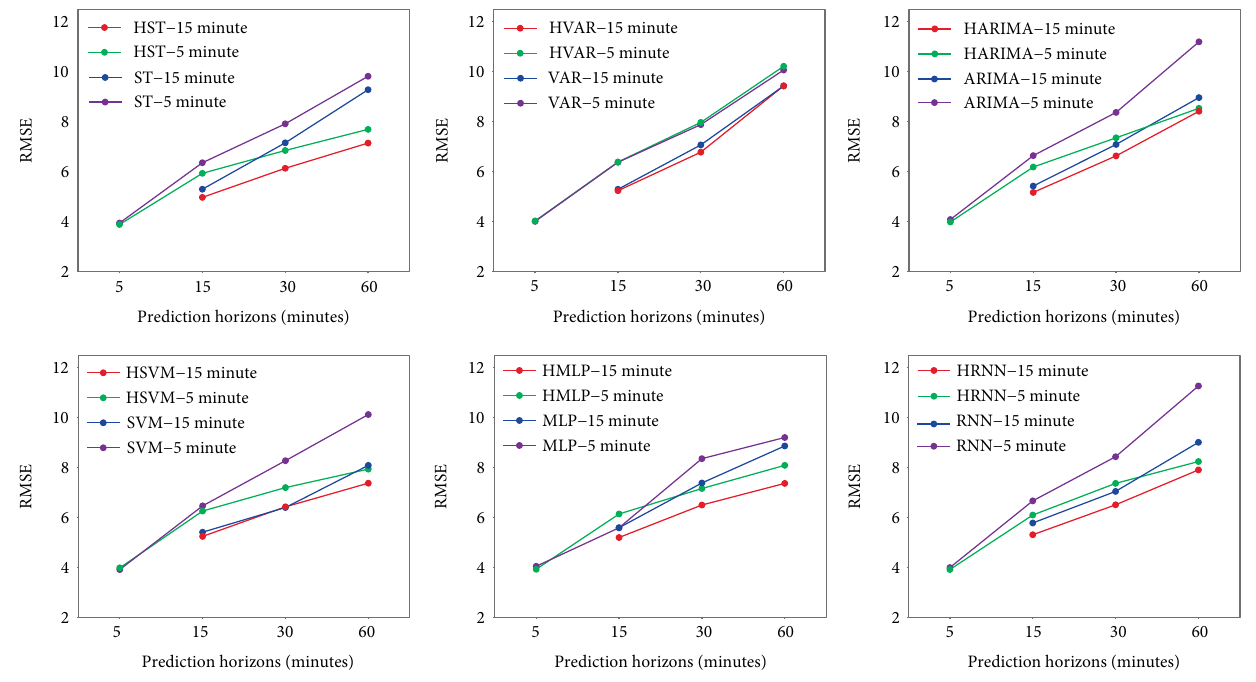
Figure 11: The RMSE values of models for different horizons and aggregation levels in off-peak hours on station